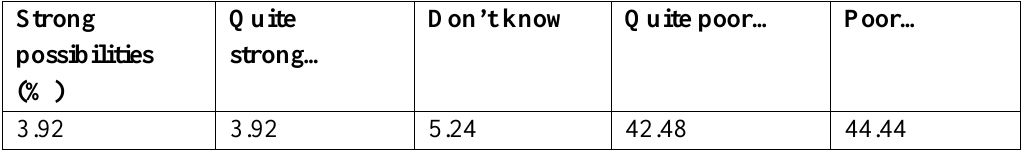
Table 5. How respondents view their prospects, as individual citizens, for influencing the development of health care reforms and